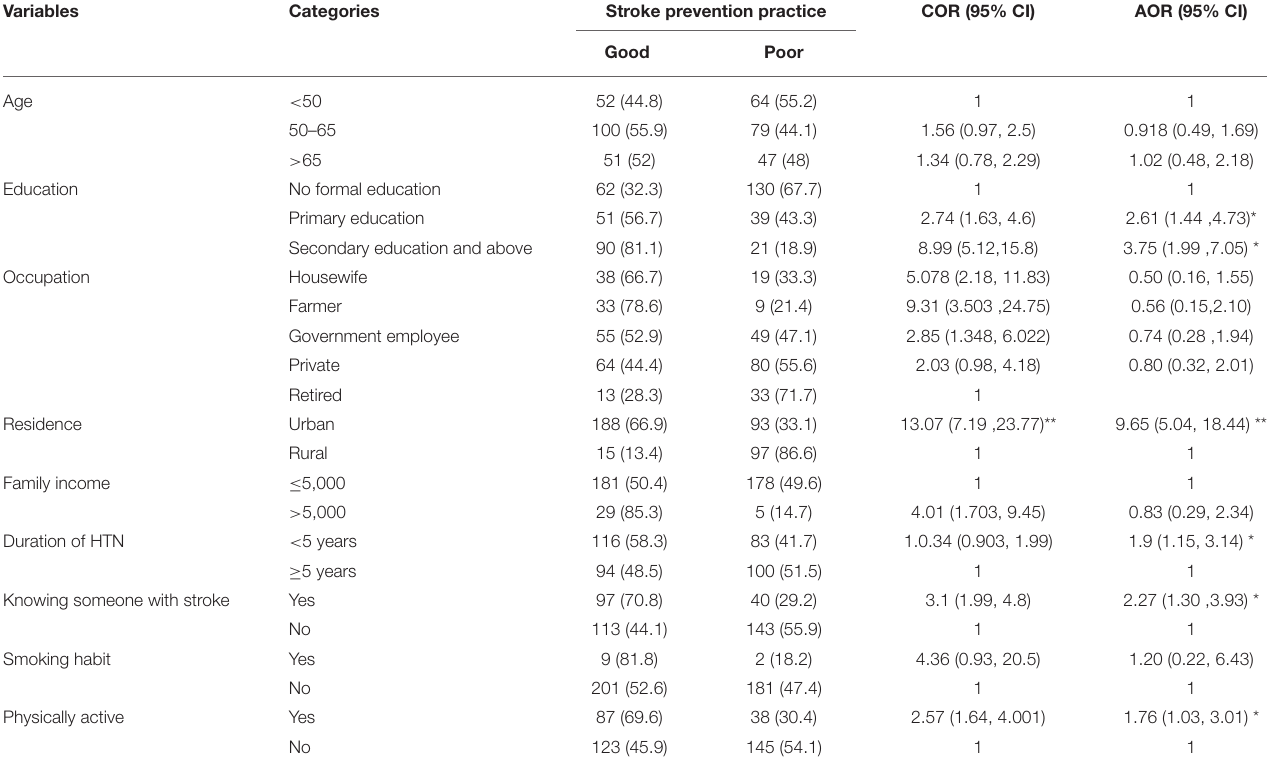
TABLE 7 | Factors associated with stroke prevention practices in hypertensive patients attending in chronic illness follow-up clinic of University of Gondar Comprehensive Specialized Hospital, Northwest, Ethiopia, 2021 ( n =